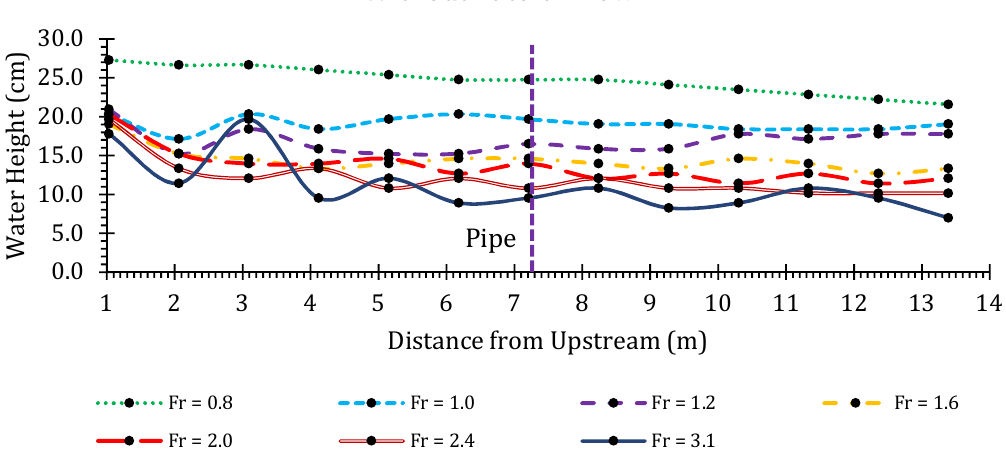
Figure 7. Water heights in the wide channel, without lateral flow.